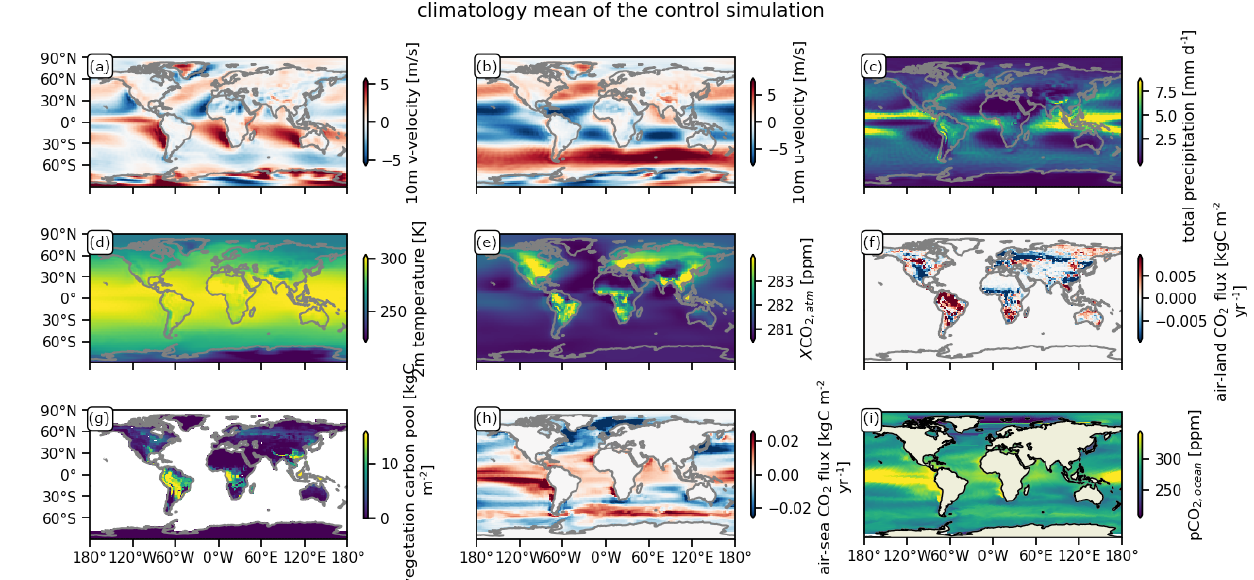
Figure G1. Mean climatology of the control simulations for all variables.